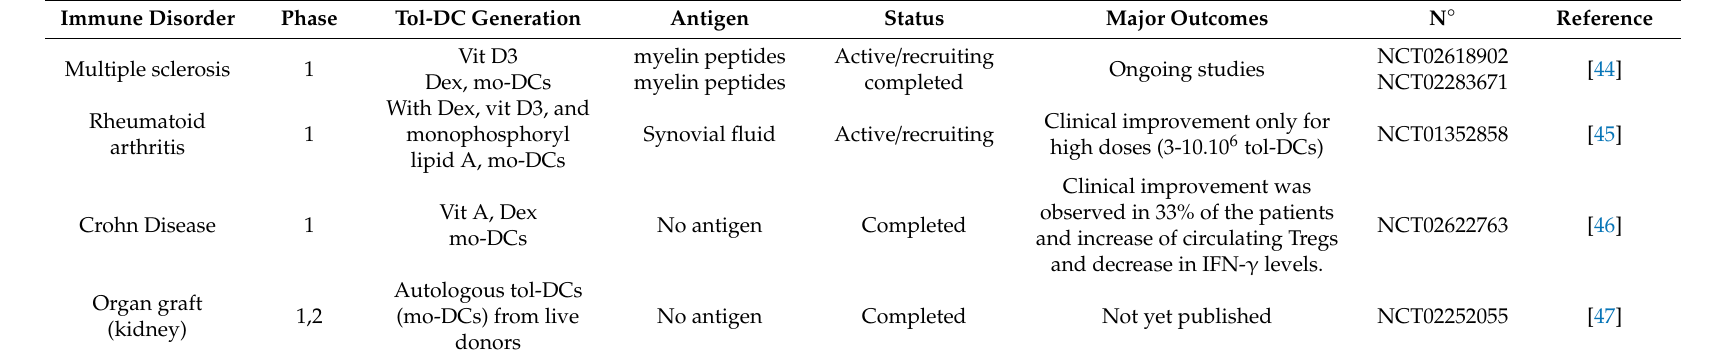
Table 2. Clinical trials involving